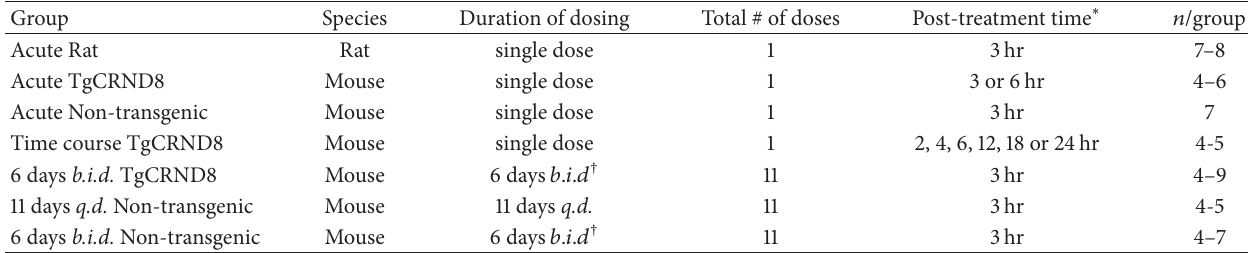
Table 1: Summary of in vivo studies conducted with SCH